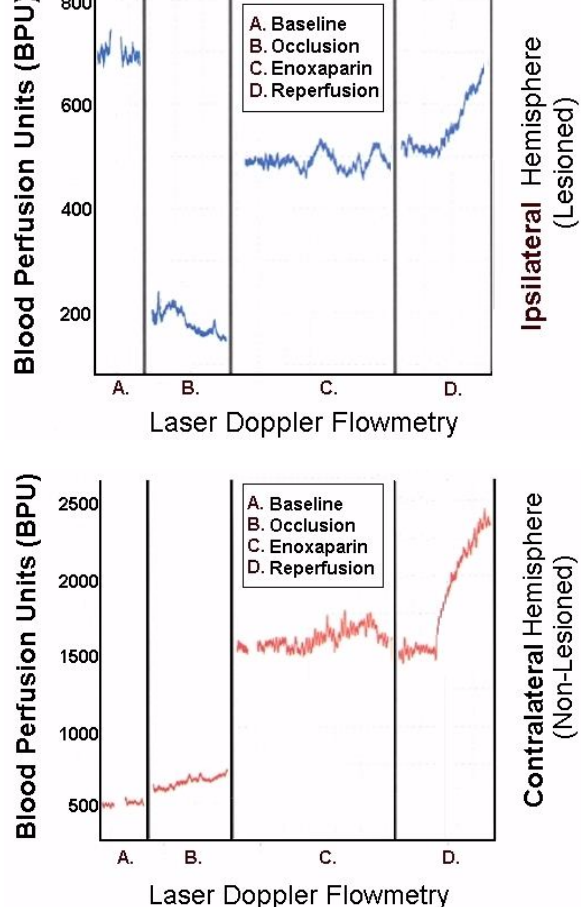
Figure 9. ( a ) Original data: results derived from dual LDF from ipsilateral hemisphere ( b ) Original data: results derived from dual LDF from contralateral